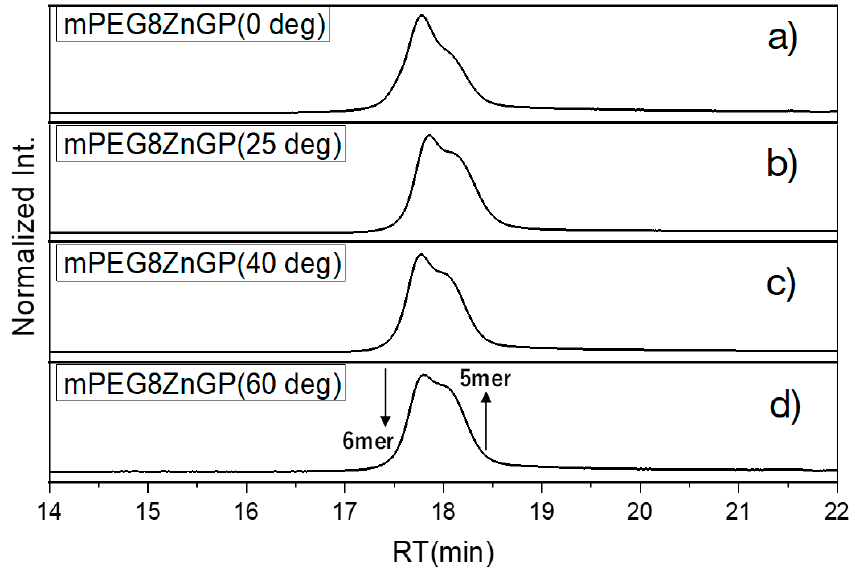
Figure 17. GPC charts of PEG8-GP1 reorganized at ( a ) 0 ◦ C, ( b ) 25 ◦ C, ( c ) 40 ◦ C, and ( d ) 60 ◦ C. (column; TOSOH TSKgel G4000H HR × 2 (exclusion limit; 400,000 Da), eluent; CHCl 3 :THF = 95:5, flow rate; 1.0 mL / min, detection; 565 nm).